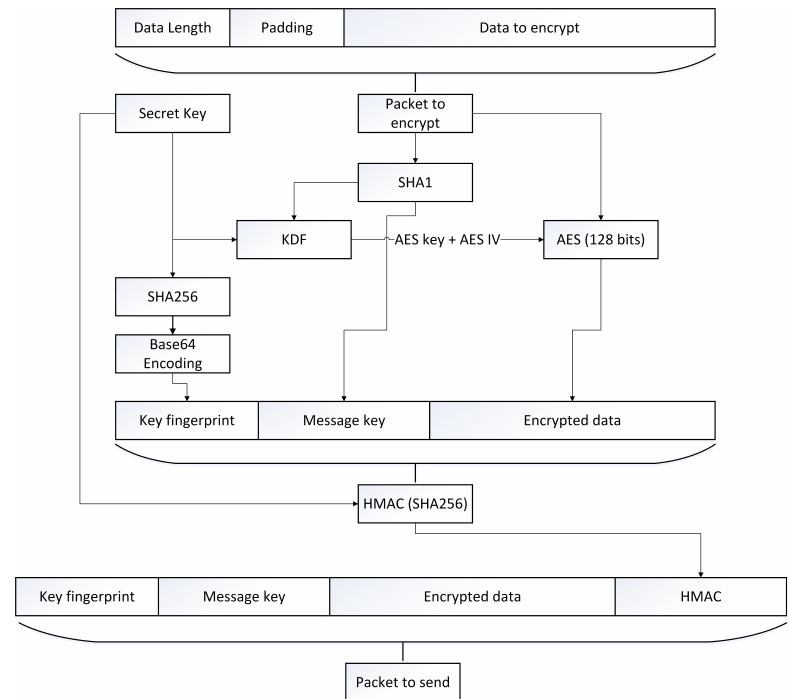
Figure 5. The encryption process. AES: Advanced Encryption Standard; KDF: key derivation number; SHA: Secure Hash Algorithm.